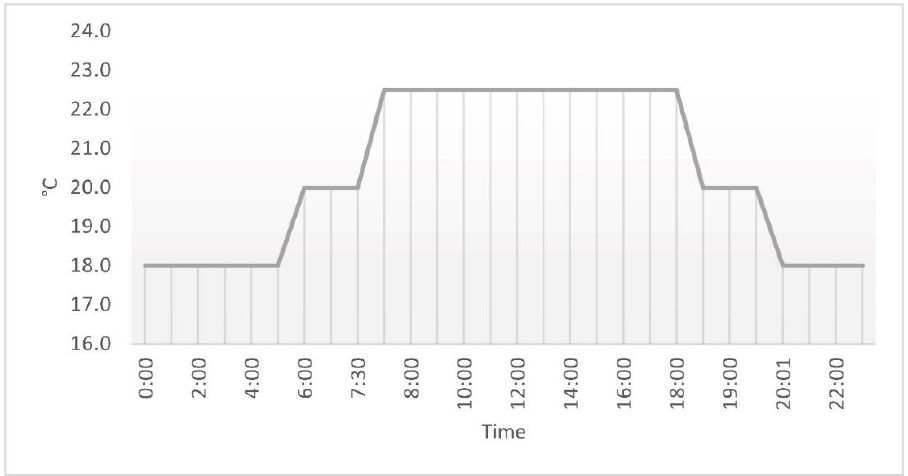
Figure 1. Temperatures cycle in the growing chamber over 24 h.